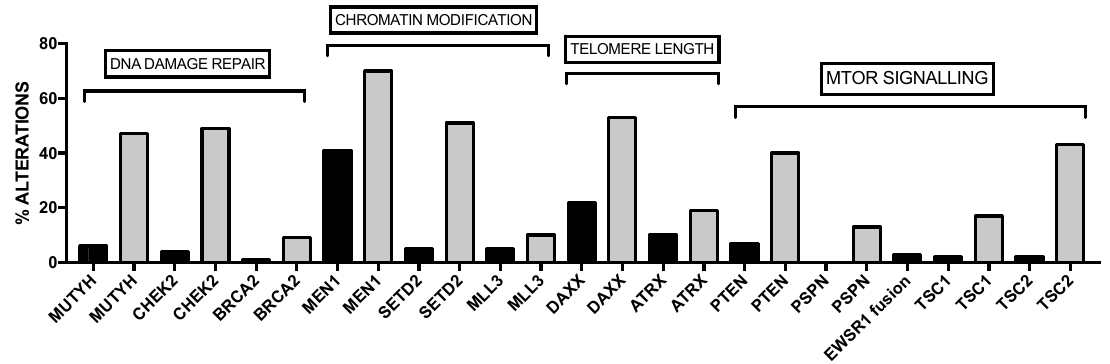
Figure 5. Frequency of the main genetic abnormalities observed in pancreatic neuroendocrine tumors (PanNET), subdivided into biochemical pathways. For each gene are reported the mutations (black bars) and copy number alterations (grey bars).